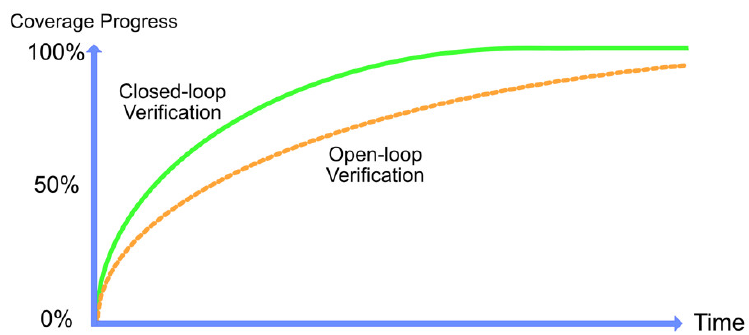
Figure 1. Impact of optimizing loop closure between coverage and stimulus using ML.